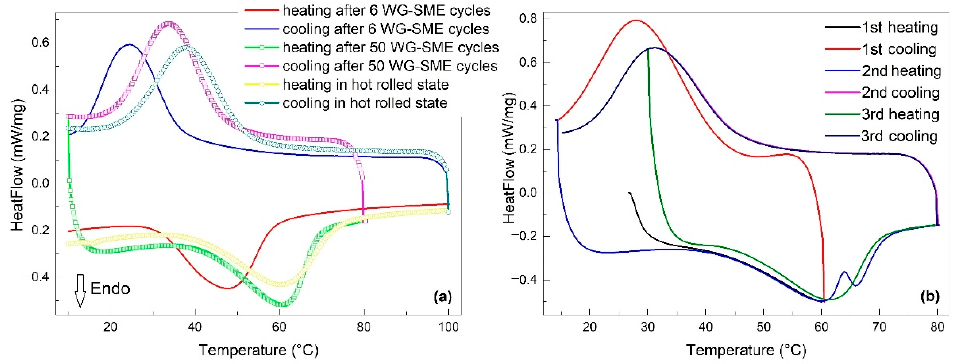
Figure 6. Heating–cooling DSC thermograms of fragments cut from specimens trained by WG-SME : ( a ) after different numbers of cycles; ( b ) temperature memory effect after 50 training cycles with 100 g load.